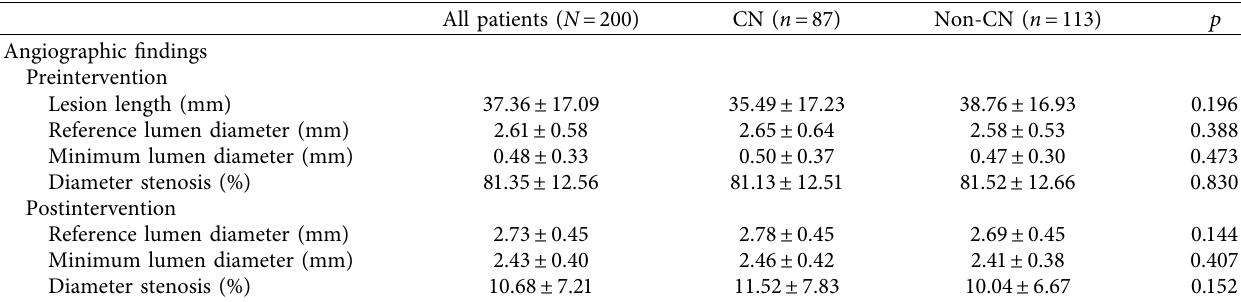
Table 3: Angiographic fndings and intravascular ultrasound fndings compared between the patients with and without calcifed